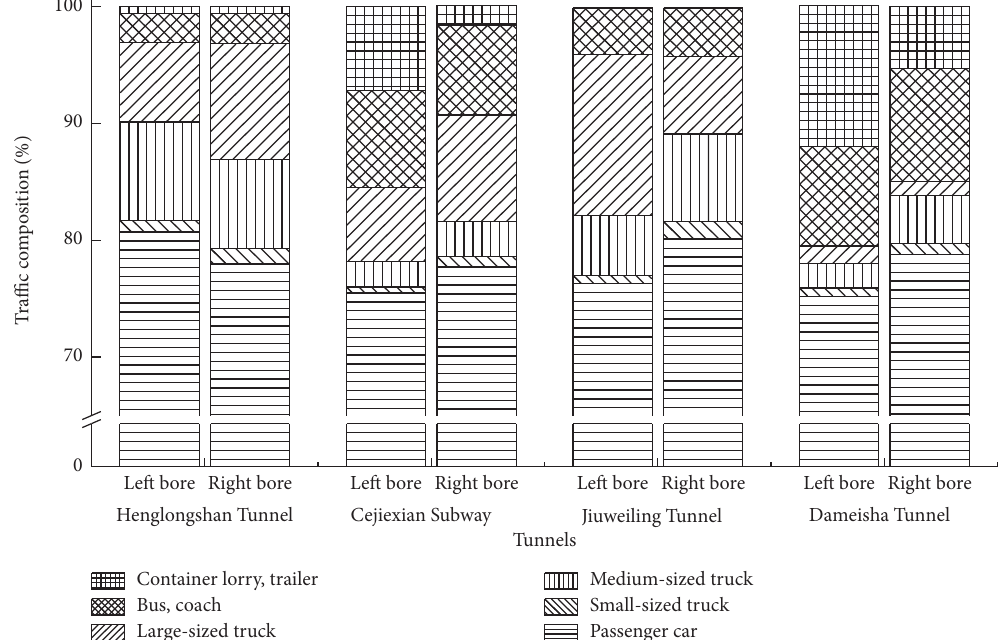
Figure 6: Traffic composition of the four urban